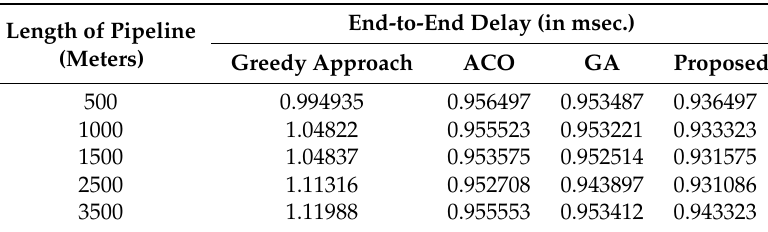
Table 3. Comparison of delay (Range 50 m).